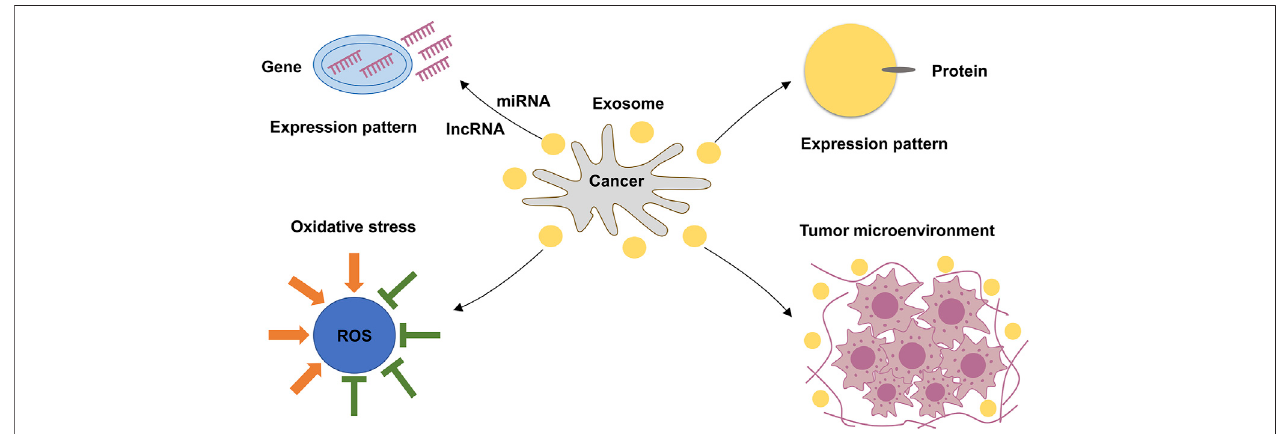
FIGURE 4 | The function of